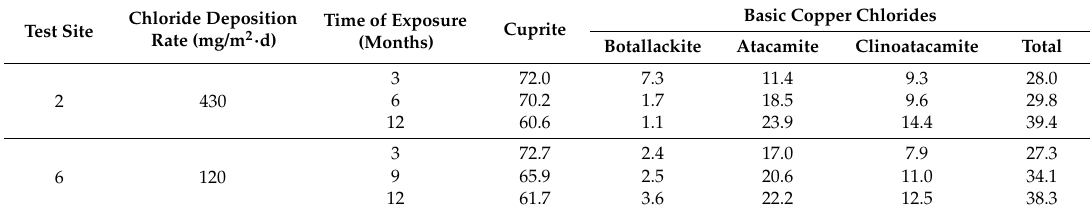
Table 6. Proportions (wt %) of the different phases integrating the patinas formed on copper in different atmospheric exposure conditions.